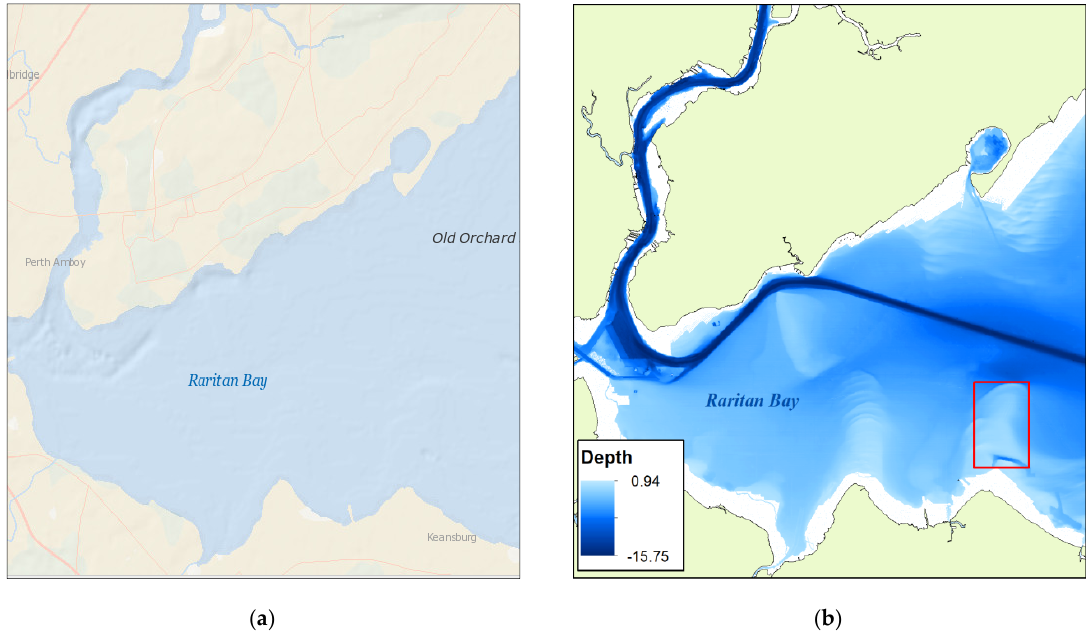
Figure 9. Case study area ( a ) NOAA National Center for Environmental Information (NCEI)) bathymetric data viewer ( b ) NOAA DTM and the area covered by Figures 10–12 (red box).